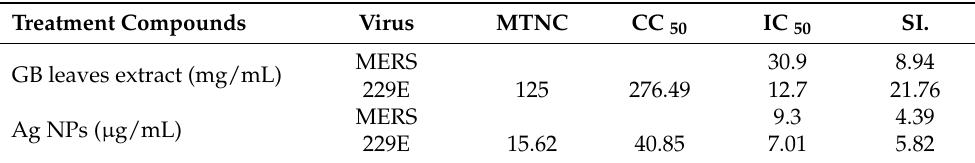
Table 5. Antiviral activity of GB leaves extract and Ag NPs anti human coronavirus (MERS-CoV and 229E). Treatment